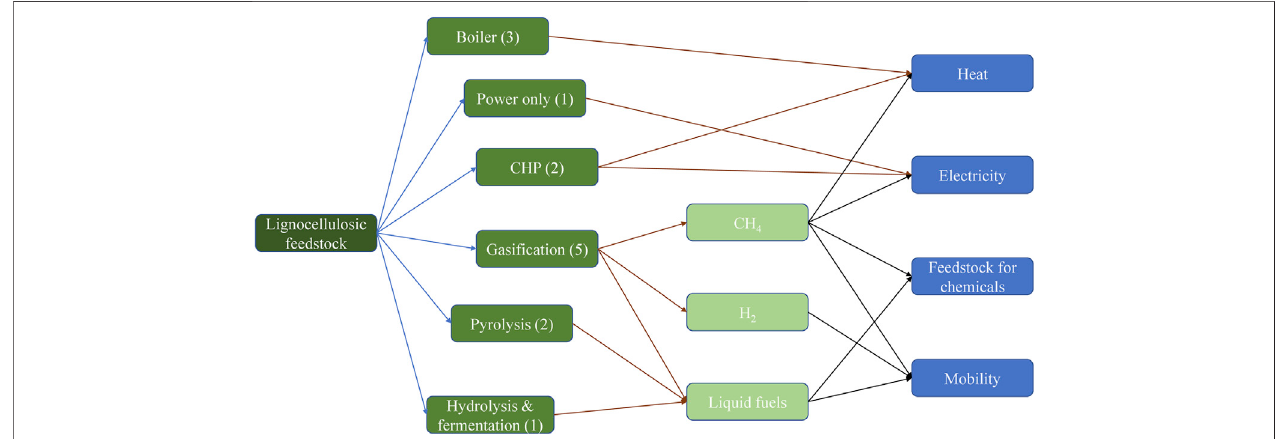
FIGURE 2 | Schematic representation of the lignocellulosic biomass technologies considered with the fi gures in brackets representing the number of different technologies considered within a category.